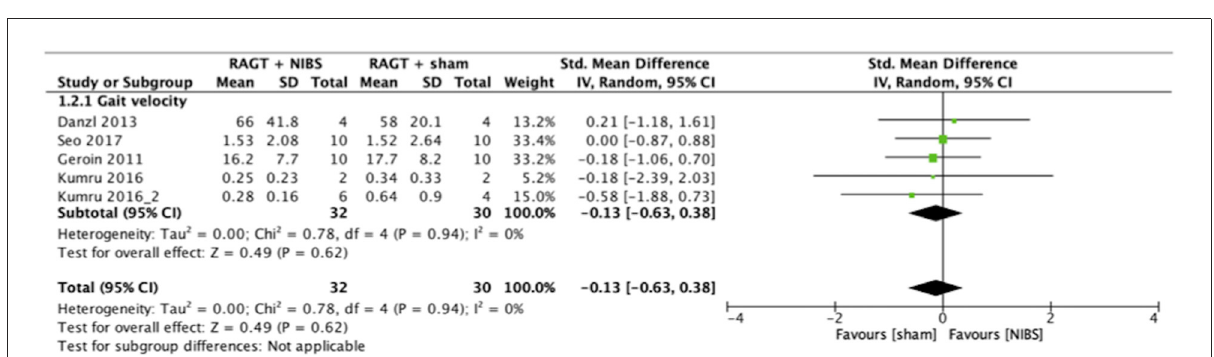
no significant differences between participants’ characteristics or types of NIBS for body function and activities of the lower